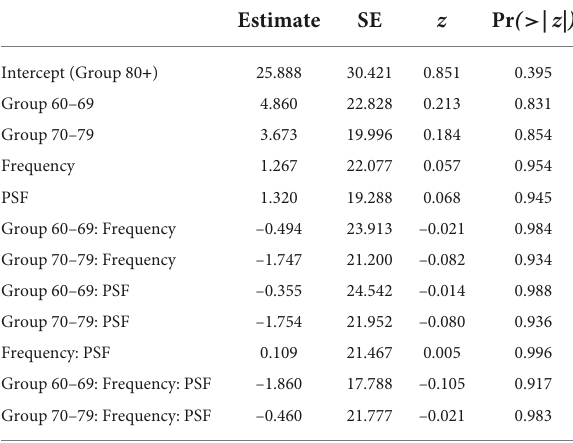
TABLE 2 Generalized linear mixed-effects regression accuracy results for Experiment